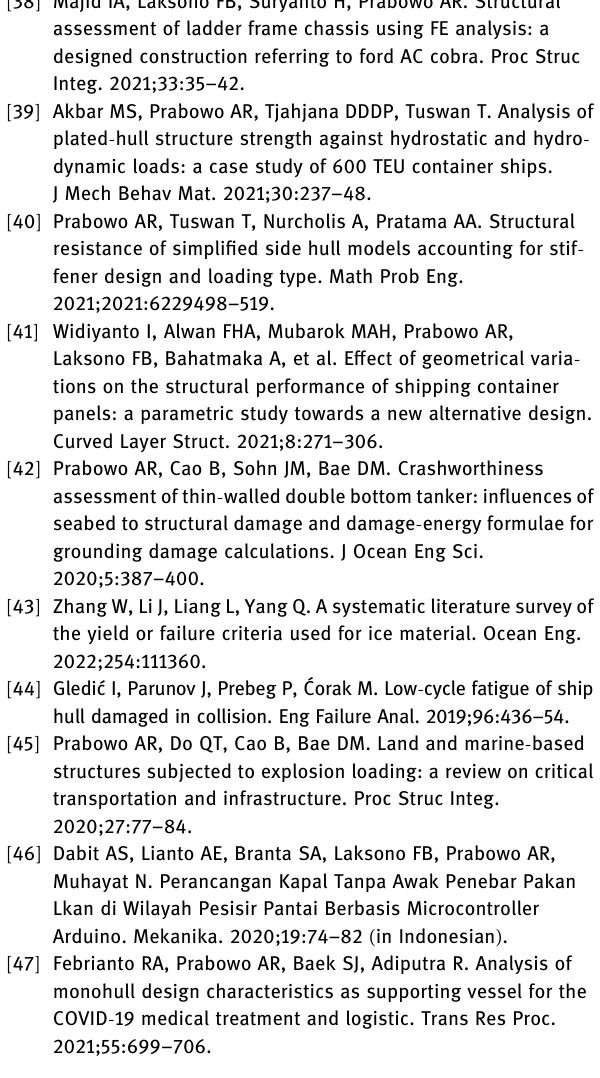
e ff ect in inter - ply S2 - glass and aramid woven composites subjected to ballistic impacts. Compos